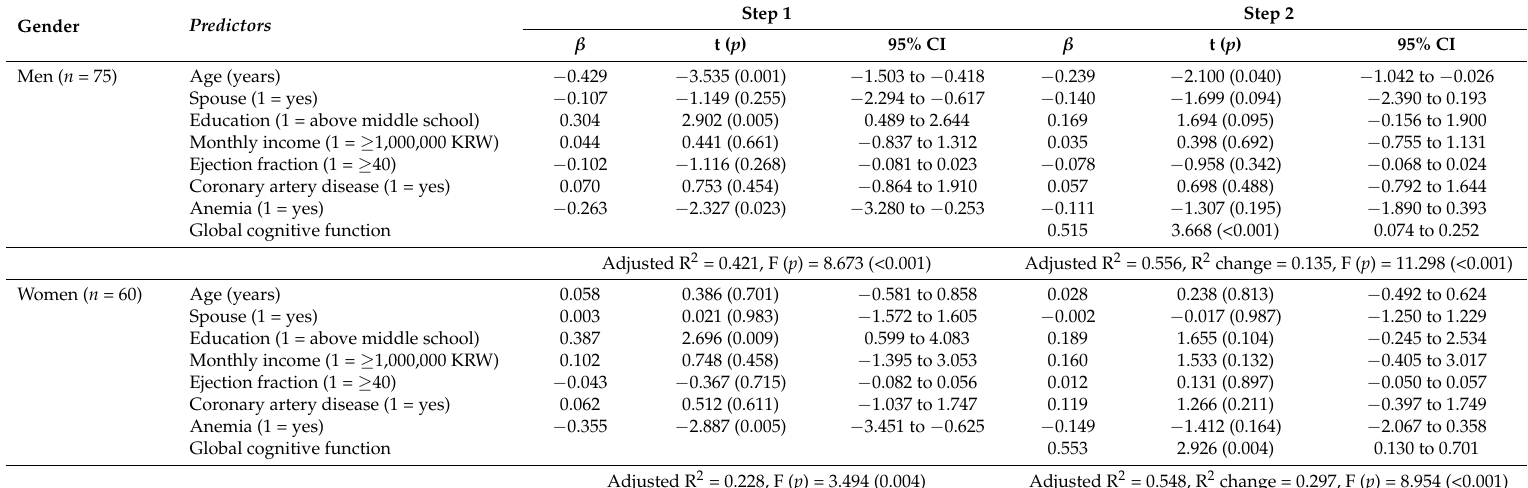
Table 3. Hierarchical linear regression analysis for health literacy in heart failure patients according to